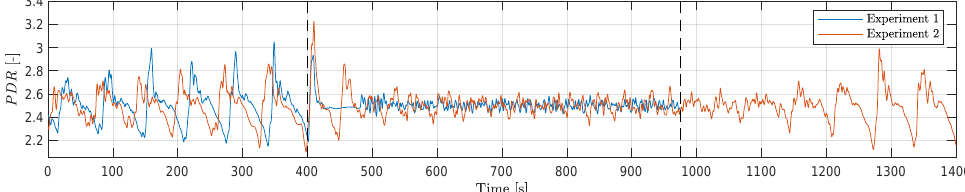
Figure 7. Shows PDR during both experiments. PDR has fluctuations that follow the slug cycles be- fore V top closes from 100% to 20%. After 400 s, the fluctuations of PDR are reduced. For experiment 2, the fluctuations of PDR are reduced as the controller actuating V top is enabled at 400 s. After 1000 s where V top is saturated most of the time, the fluctuations of PDR